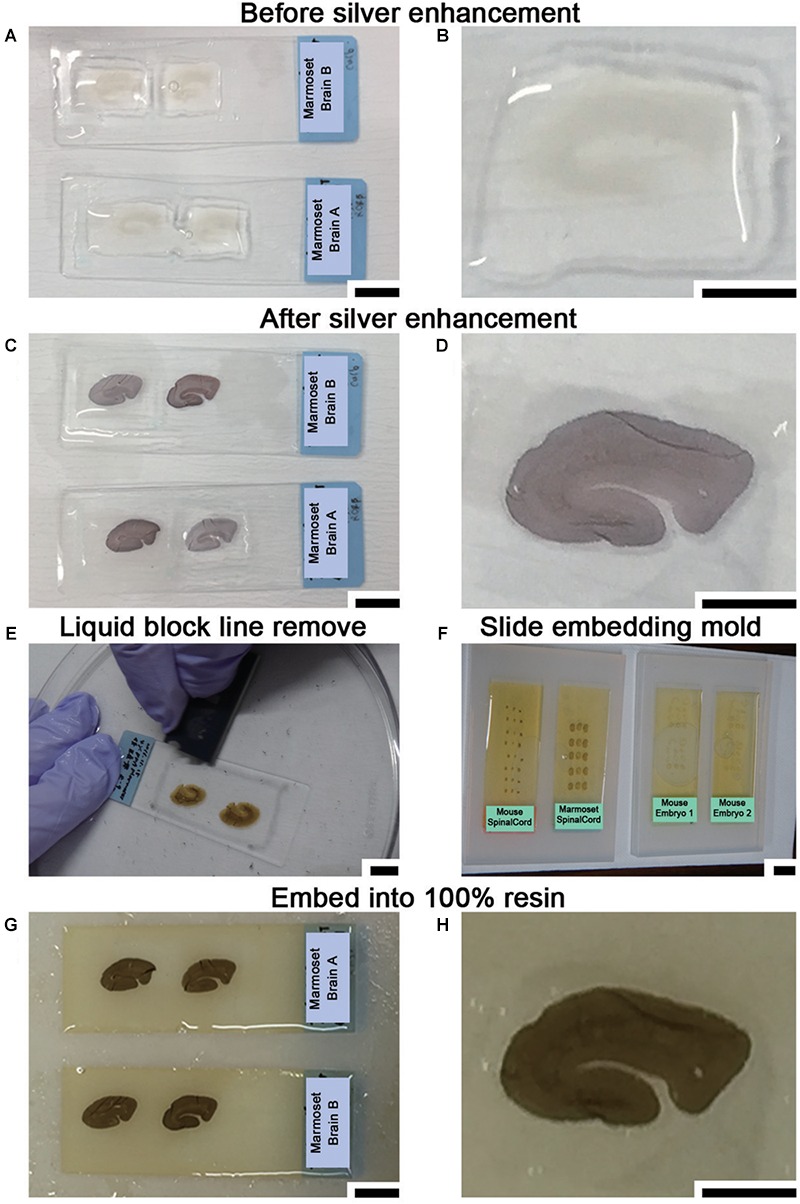
Sample preparation for LA-CLEM using resin blocks. (A,B) Silver enhancement was required to visualize the localization of specific molecules using nanogold-conjugated antibody signals. (C,D) The tissue became slightly darker when the silver enhancement procedure was completed. (E) At the middle of the dehydration step with 100% EtOH, the lines on the slide glass applied with liquid blocker should be removed from the top using a single-edged razor blade. If this step is omitted, it may be difficult to remove the section smoothly from the slide glass after resin polymerization. (F) Dehydrated and resin-infiltrated samples were embedded in a silicone mold for slides. Air bubbles under the slides should be removed before beginning polymerization. (G,H) Brain slices stained with antibody were fully polymerized by incubating at 60°C for 72 h. Scale bars: (A,C,E)–(G) 1 cm; (B,D,H) 5 mm.